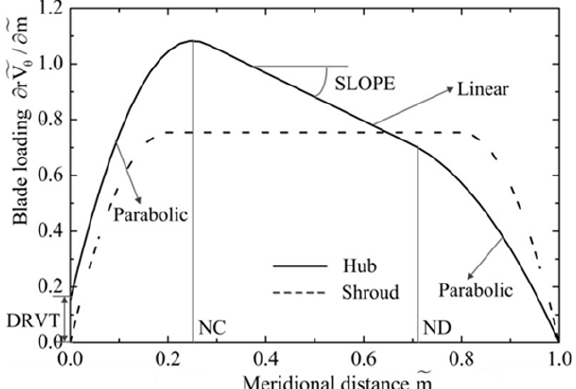
Figure 6. Blade loading distributions.